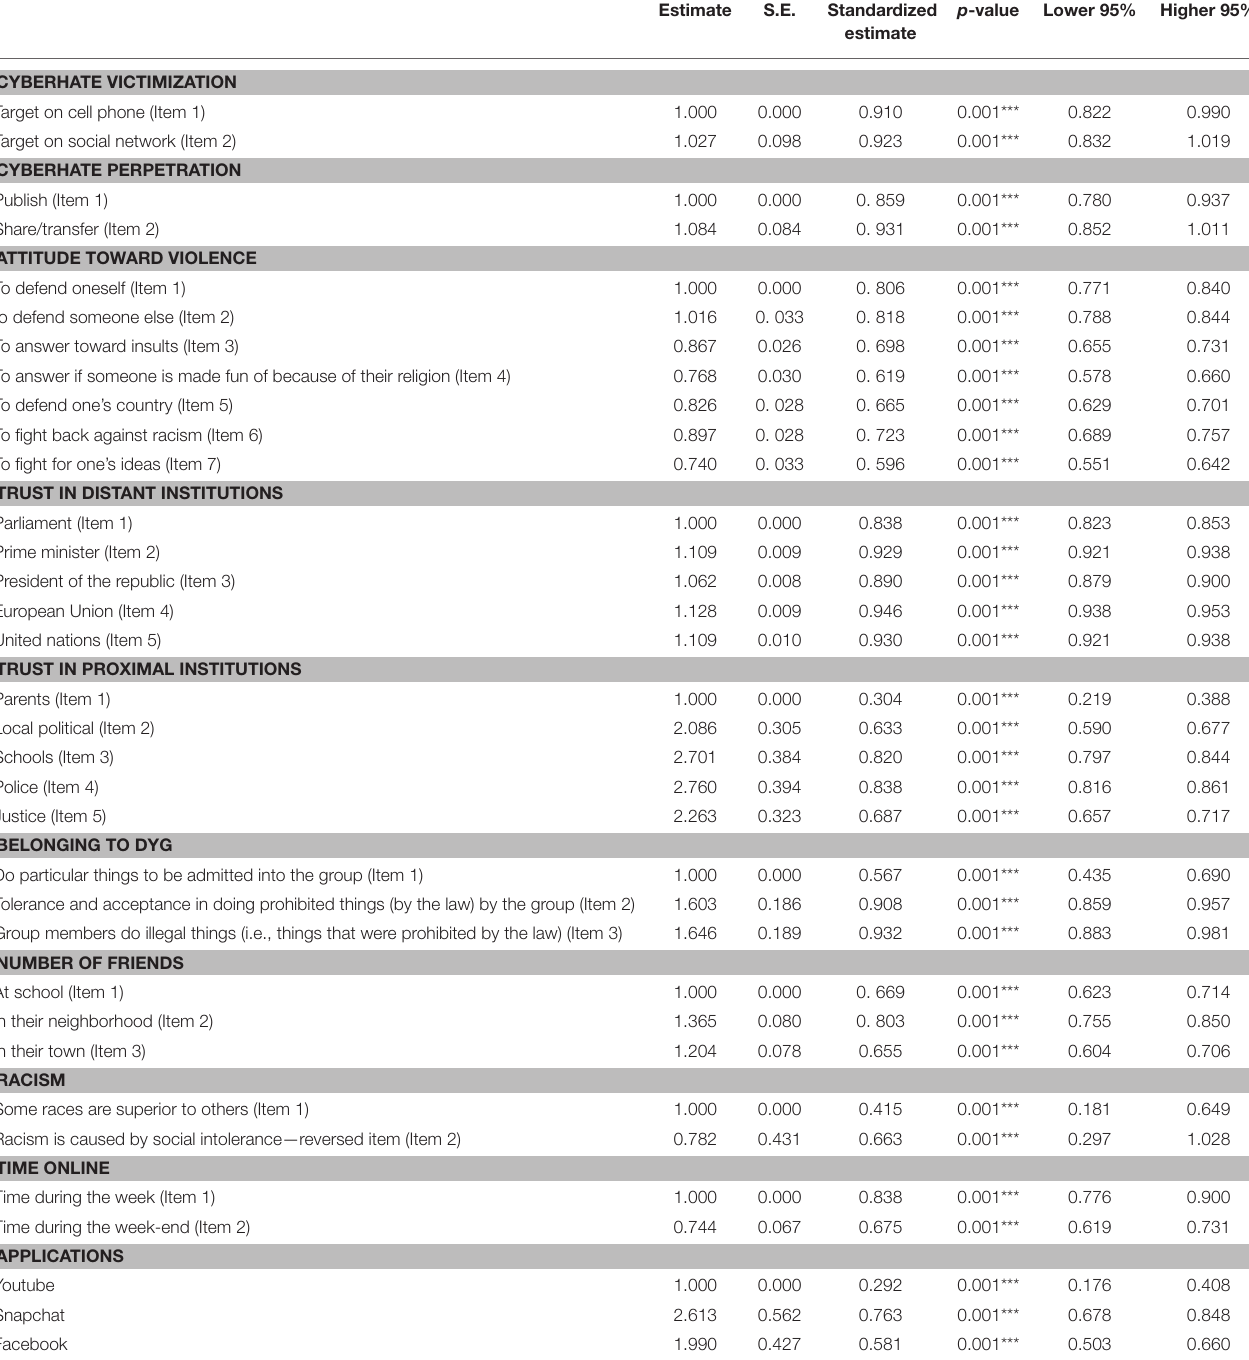
TABLE 6 | Factor loadings for each latent variable.